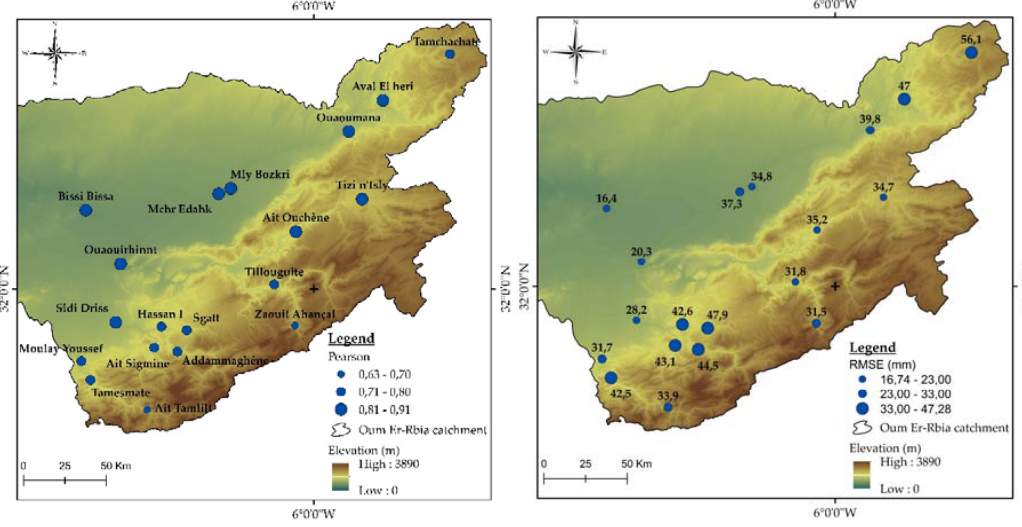
Figure 6. Pearson correlation coefficient based on topography and RMSE based on mean monthly rainfall.